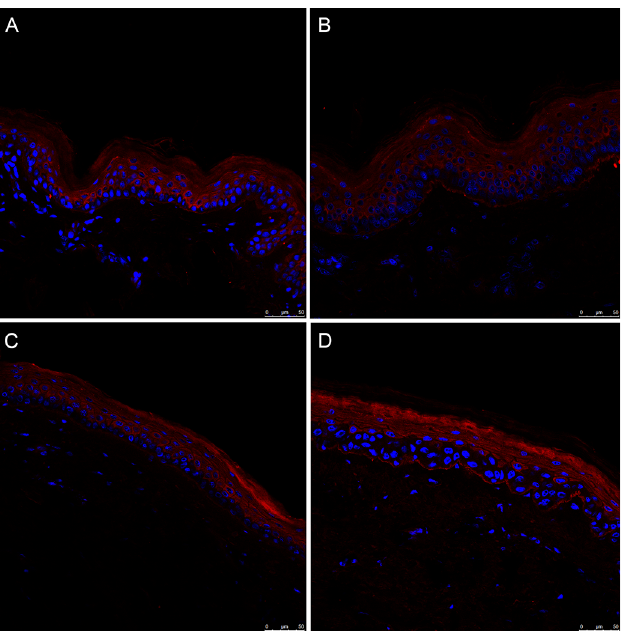
Fig 3. Basal levels of autophagy marker LC3 in full thickness human skin sections from young and old donors. Representative fluorescence confocal photomicrographs for LC3 (red fluorescence) and DAPI is used for nucleic staining (blue fluorescence). (A) skin section from the photo-protected upper arm of a young donor, age 27 yr. (B) skin section from the photo-exposed lower arm of the same young donor. (C) skin section from the photo-protected upper arm of an old donor, age 60 yr. (D): skin section from the photo- exposed lower arm of the same old donor.